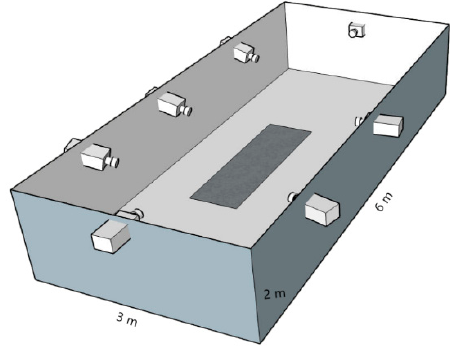
Figure 1. Camera placement during the 3D kinematic data collection.